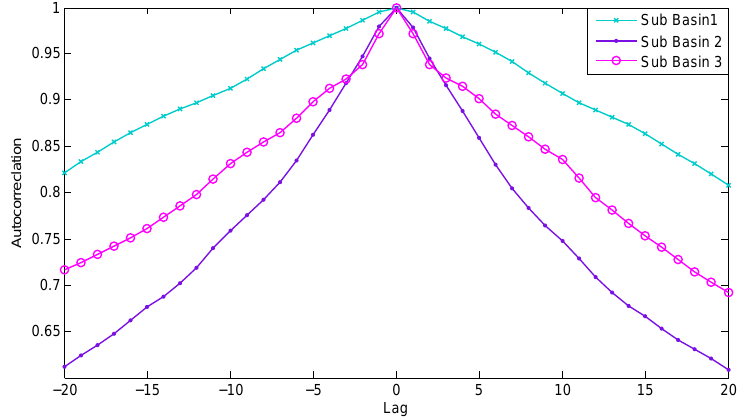
Figure 3. Autocorrelation function of streamflow time series.